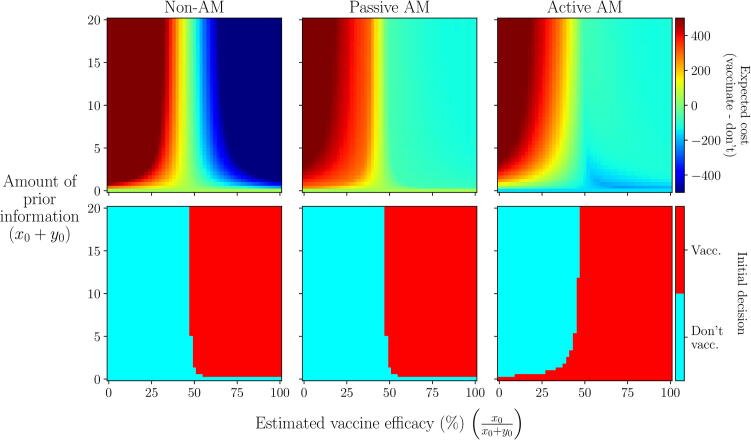
Scenario 1: Initial decision made under each approach given different prior information. We define prior information using a Beta(x0+1,y0+1) distribution and vary the estimated efficacy (the mode of the distribution; x0x0+y0) and the amount of information supporting this estimate (x0+y0). Top row: difference in expected cost between vaccinating initially or not, as viewed under each approach. Bottom row: initial decision made under each approach: vaccinate (red) or not (blue). Epidemiological and vaccination parameters are set to those in Table A.2: Scenario 1.